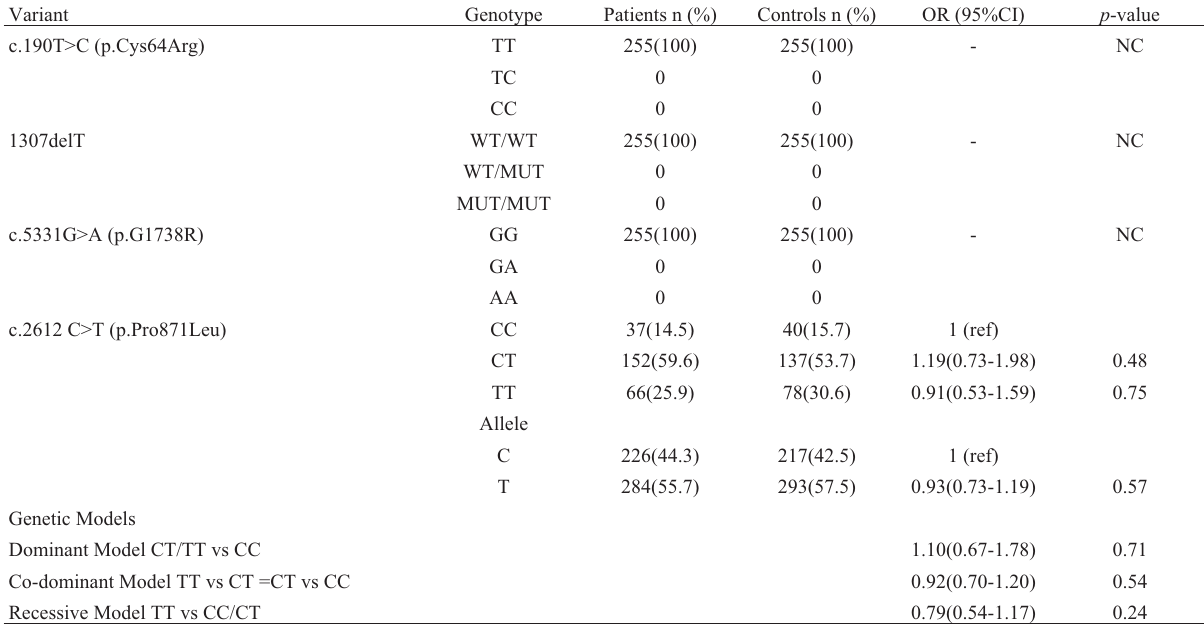
Table 4 - Association analyses of BRCA1 variants with breast cancer